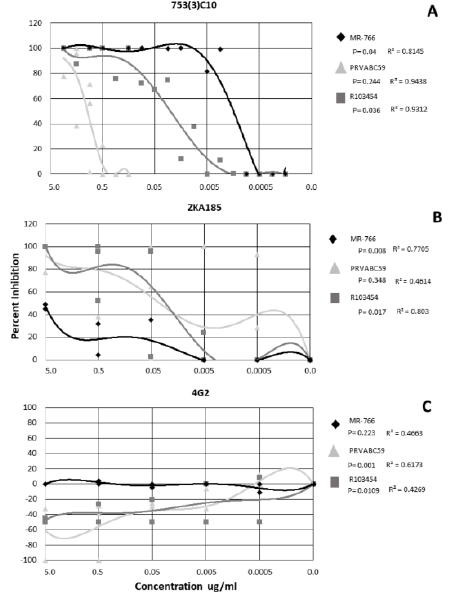
Figure 1. Neutralization and enhancement of Zika by 3 monoclonal antibodies. Non-linear regression was performed to identify significance. Each shape represents the average inhibition of 2 replicates.